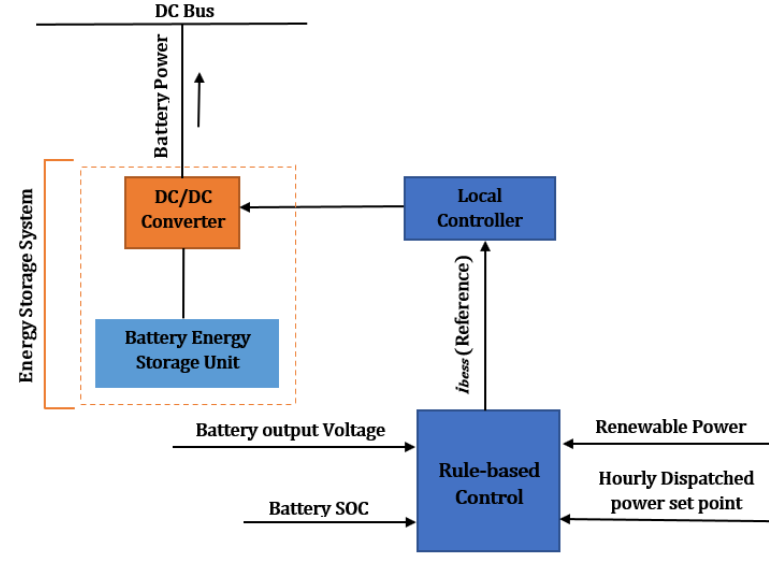
Figure 8. Rule-based control.